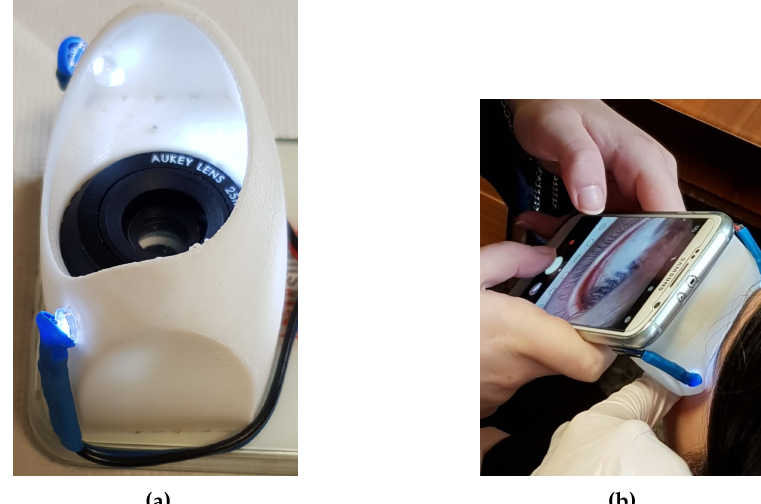
Figure 2. ( a ) The acquisition device consists of a special spacer and a macro lens to acquire images with a high-resolution smartphone at close range; ( b ) the moment of the acquisition of an image of the